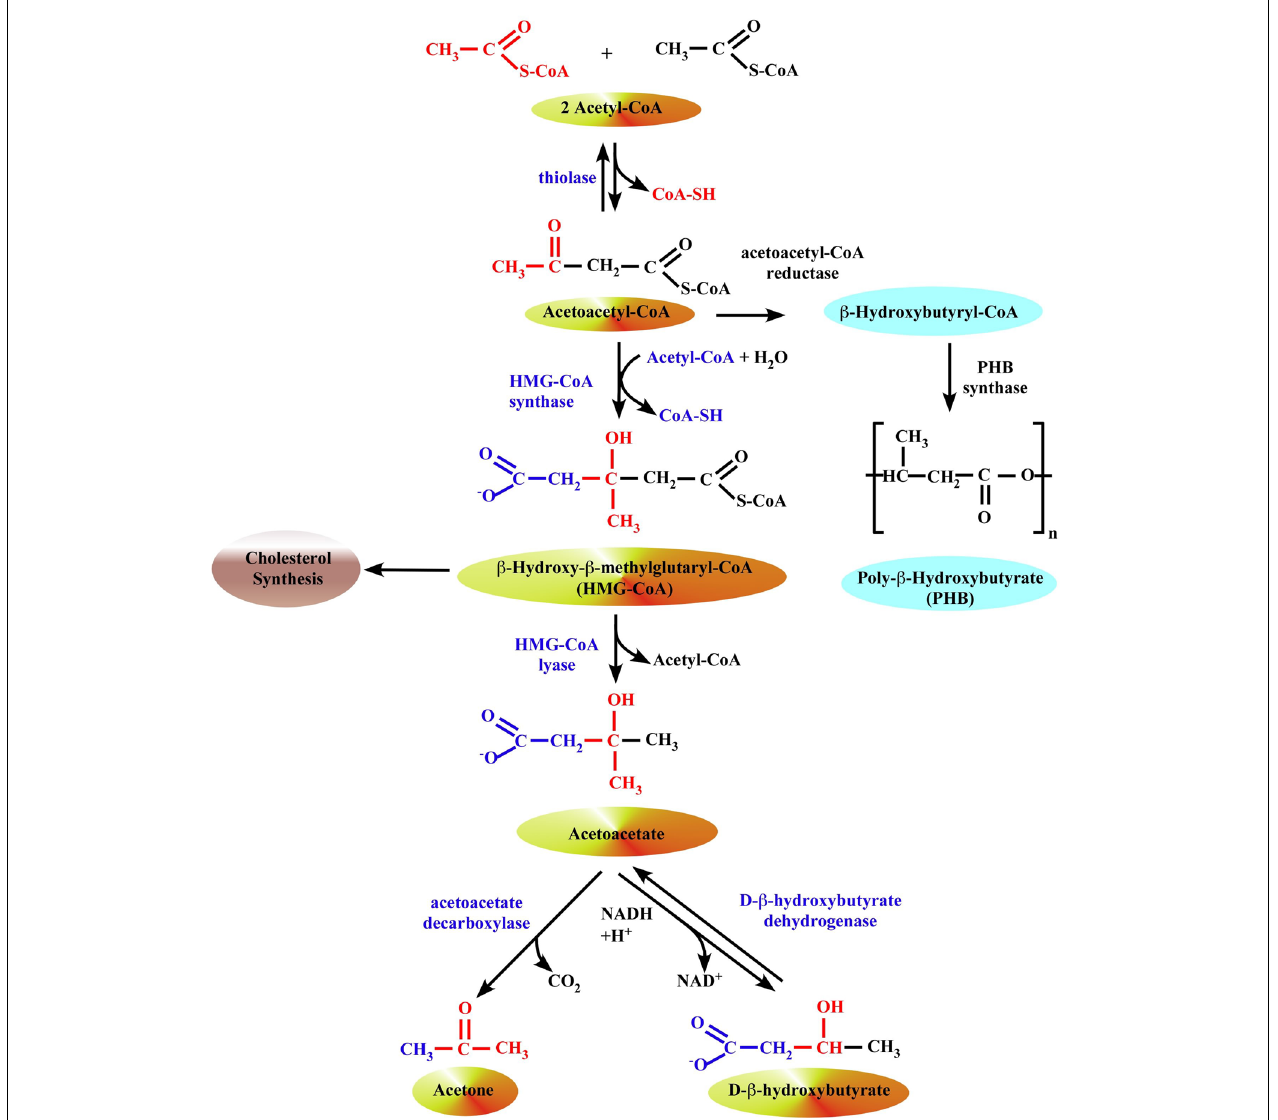
FIGURE 1 | Formation of ketone bodies in liver mitochondria. The synthesis of β -OHB begins with the condensation of two molecules of acetyl-CoA to form acetoacetyl-CoA, the parent of the three ketone bodies, by a ketothiolase enzyme. In prokaryotes, this intermediate is subsequently reduced with NADPH to hydroxybutyryl-CoA by acetoacetyl-CoA reductase, and hydroxybutyryl-CoA may then be polymerized to form PHB by the enzyme PHB synthase. In eukaryotes, 3-hydroxy-3-methylglutaryl-CoA synthase (HMG